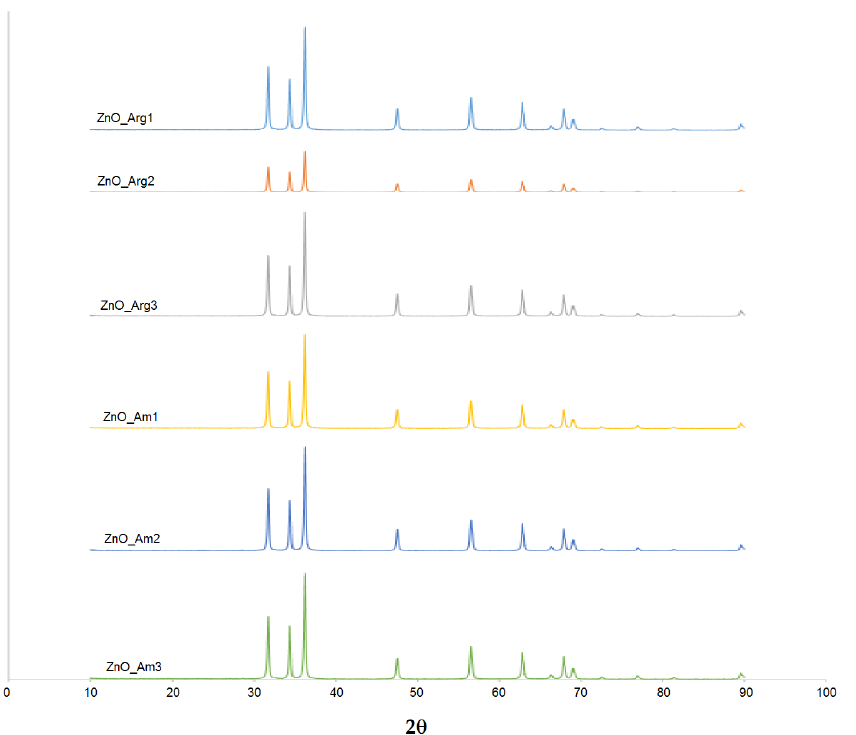
Figure 2. Representative XRD spectra of ZnO NPs prepared under various conditions. Details of encoding are summarized in Table 1.